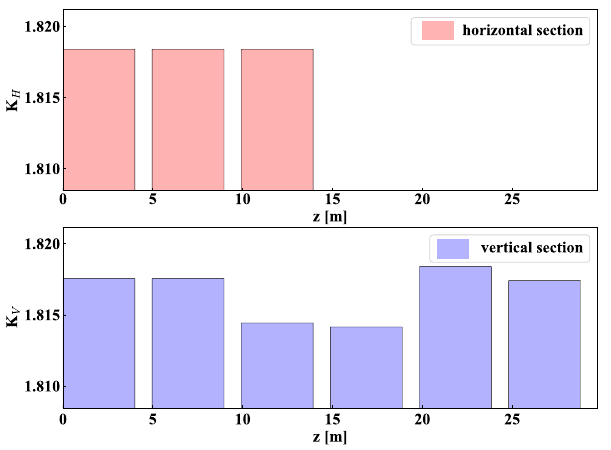
FIG. 2. The undulator parameters in the first undulator section. The optimized taper profile of the second undulator section. Each parameter of the six undulators is optimized to match the pulse energy produced by the first undulator